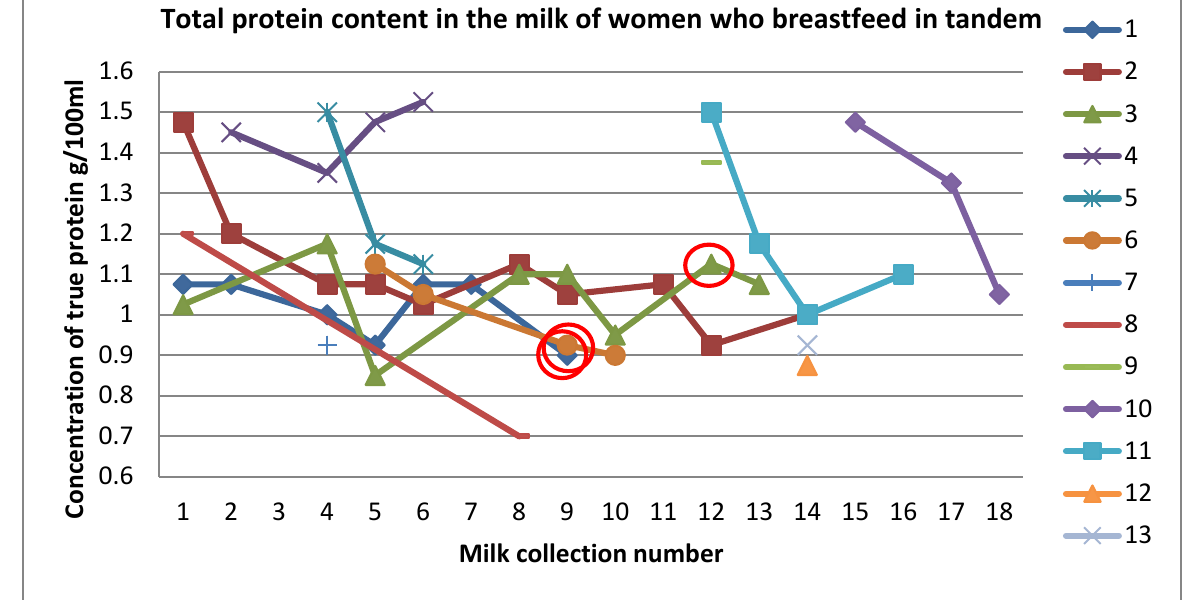
Chart 2. Individual changes in total protein content. The weaning time is indicated by the red circle, 1–10 monthly milk collection.